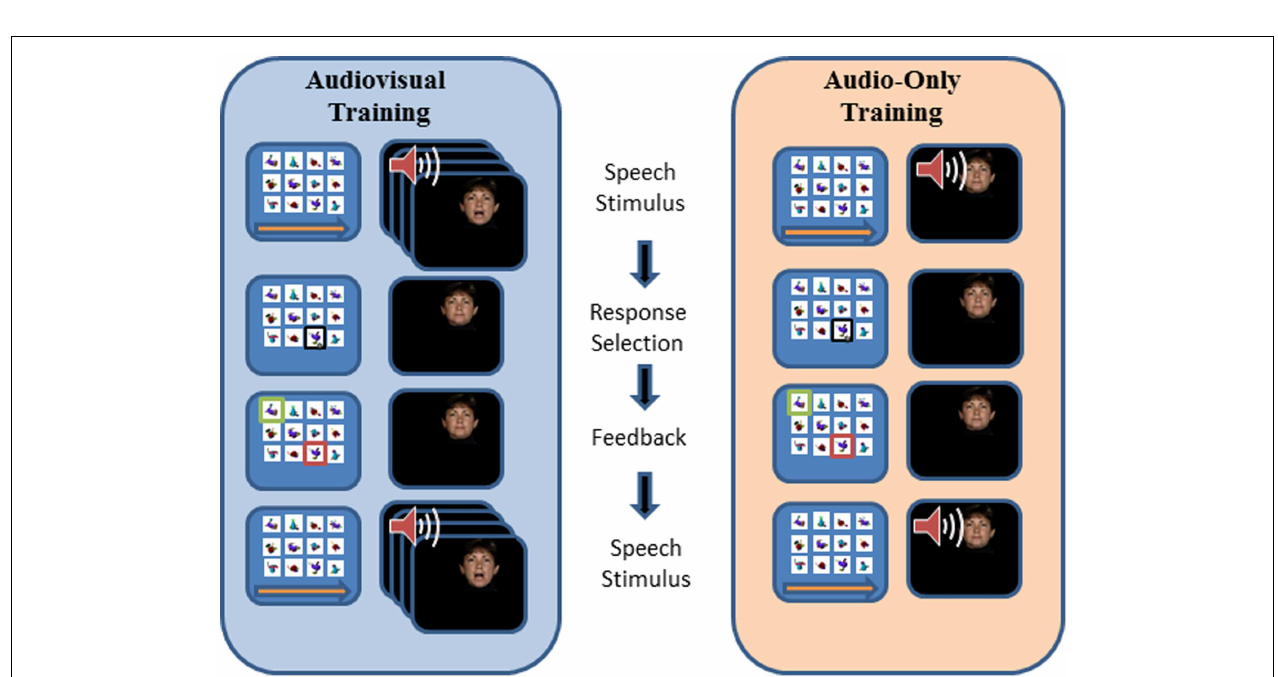
showing the talker.The trial structure for AV and AO training followed the same sequence, except that during AV training the video was played synchronously with the audio, and during AO training a still neutral face was played during the audio.